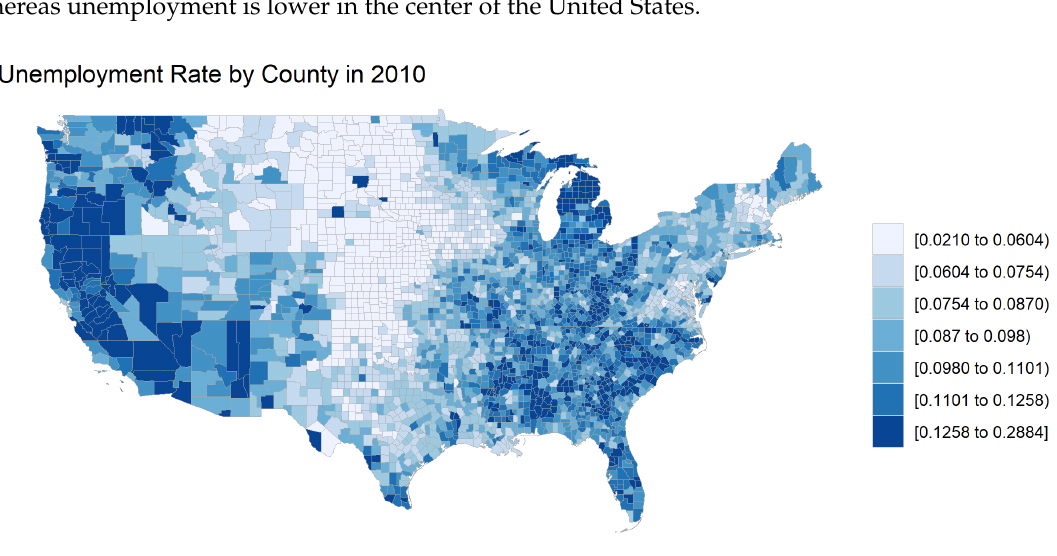
Figure 4. Unemployment rate by county in